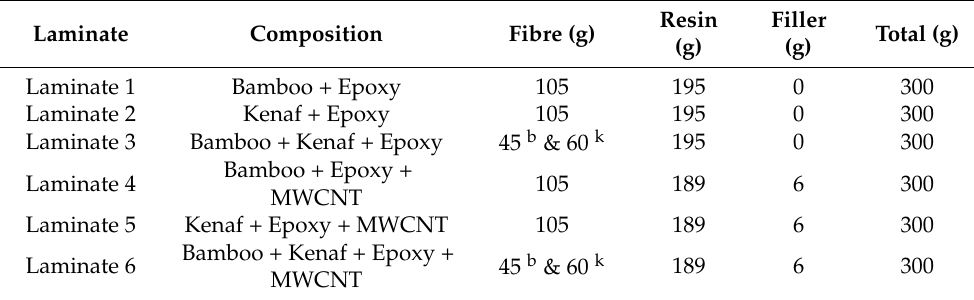
Table 1. Composition of prepared laminates with varying amounts of natural fibres, Epoxy resin and MWCNT fillers. Superscripts b and k indicate compositions of Bamboo and Kenaf fibre,